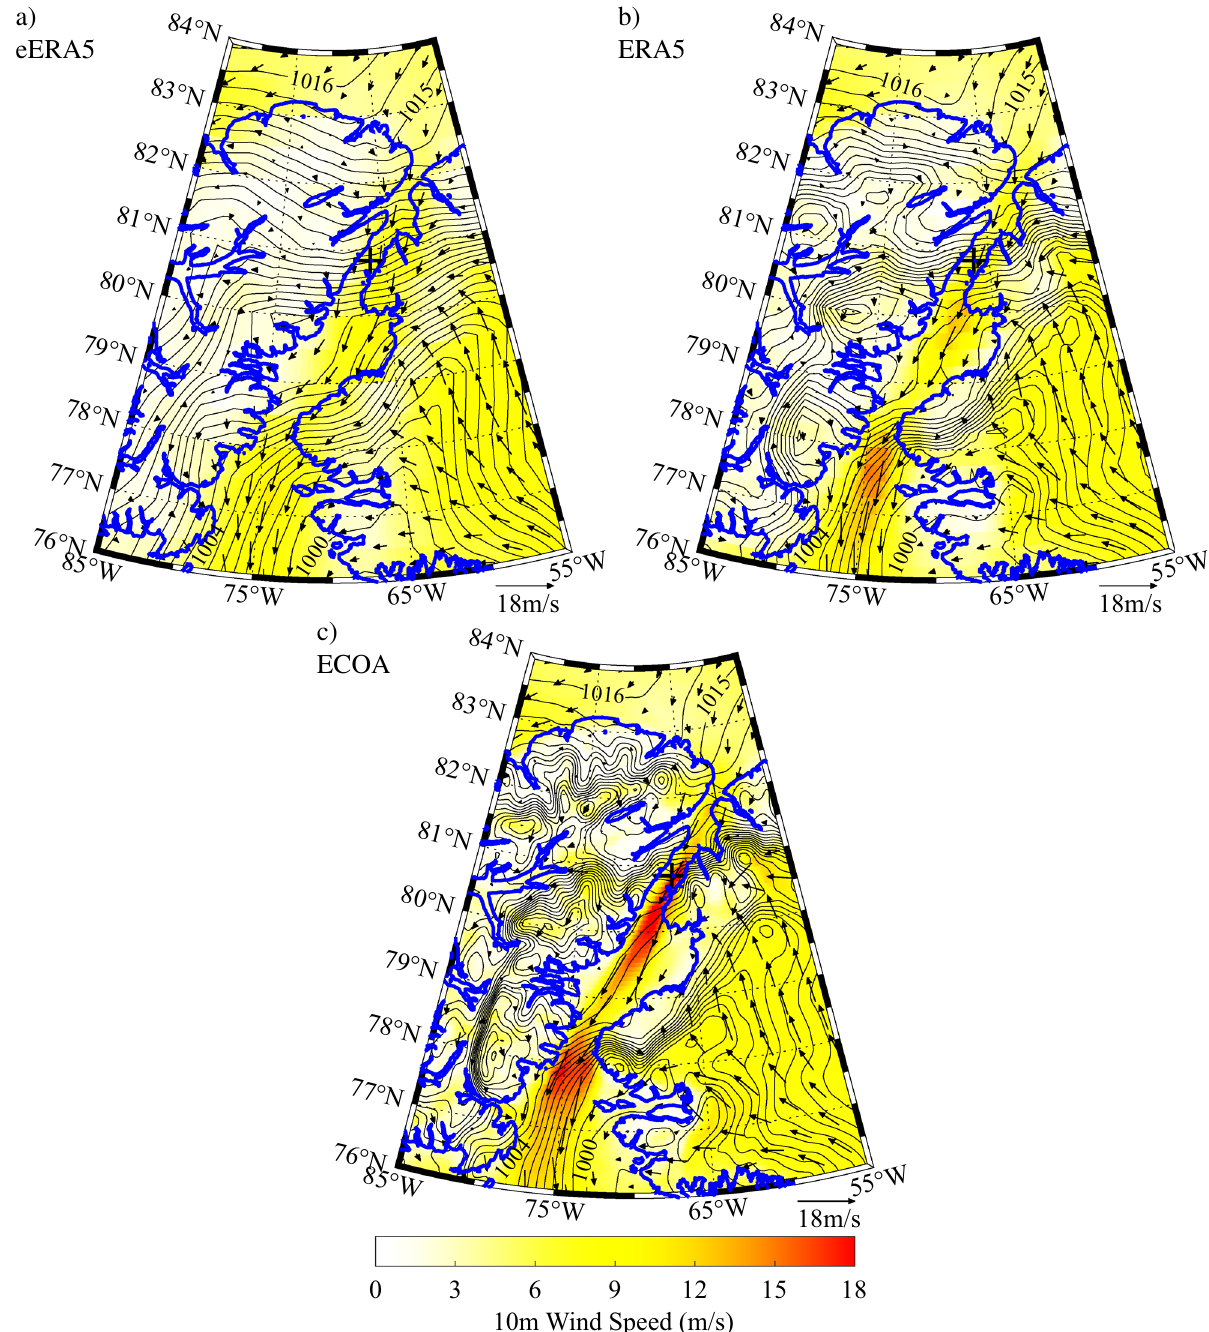
Figure 10. Composite sea-level pressure (contours-mb), 10 m wind speed (shading-ms −1 ) and 10 m wind (vectors-ms −1 ) for high speed northerly flow at Hans Island as represented in the: (a) eERA5, (b) ERA5 and (c) ECOA. Figure created using Matlab R2019b (https:// www. mathw orks.